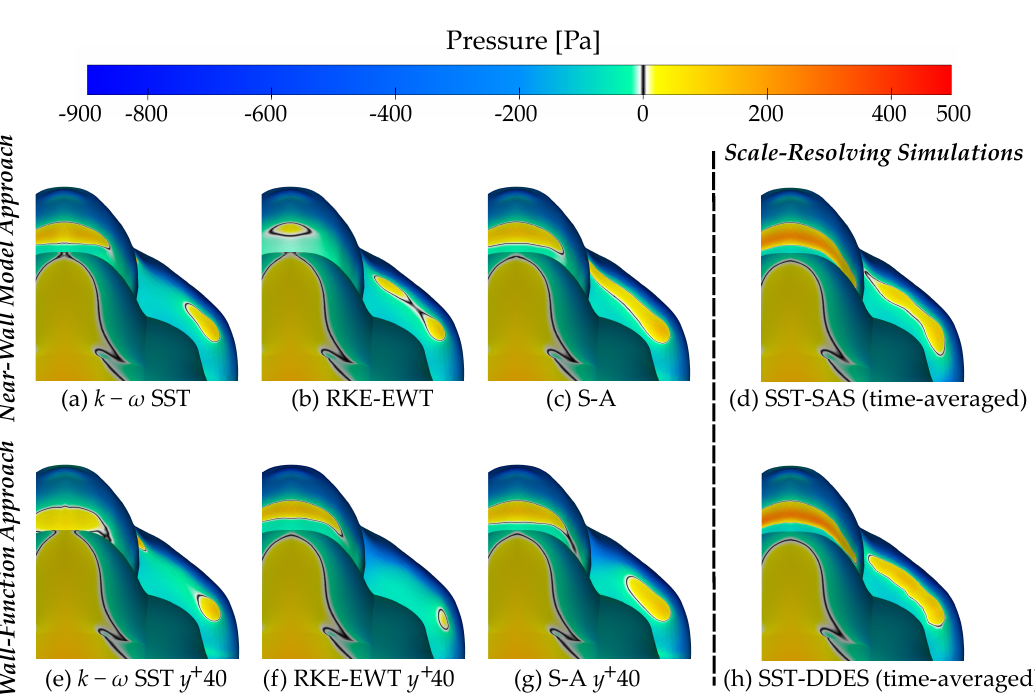
Figure 9. Comparison of static pressure contours for: ( a ) k − ω SST, ( b ) RKE-EWT and ( c ) S-A models using the near-wall model approach and the same models using the wall-function approach: ( e – g ) together with SRS models (time-averaged): ( d , h ) in the vicinity of the windscreen and the riders